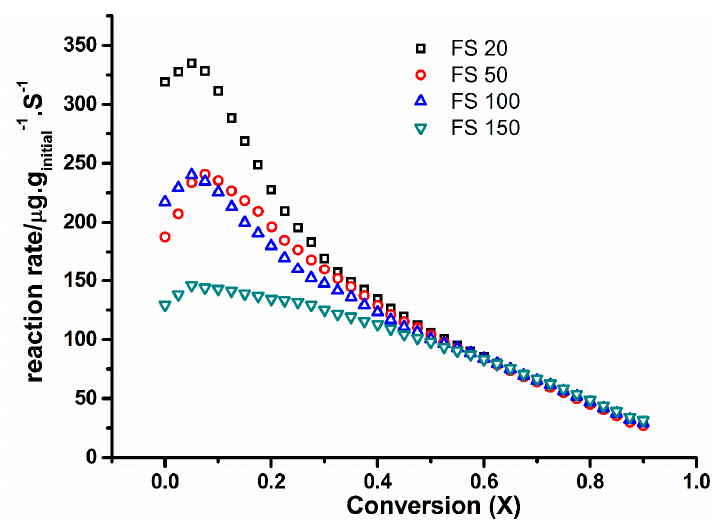
Figure 6. Isothermal soot oxidation curves at 525 °C for flame soot collected from different heights. Feed: 10% O 2 .